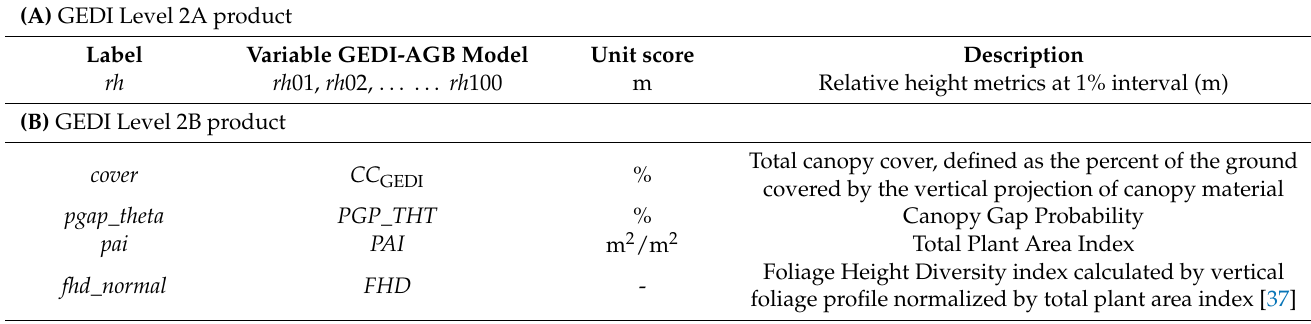
Table 2. Set of statistics derived from GEDI Level 2A (L2A) and Level 2B (L2B) data computed for the ground-footprint location of GEDI laser beams across the training